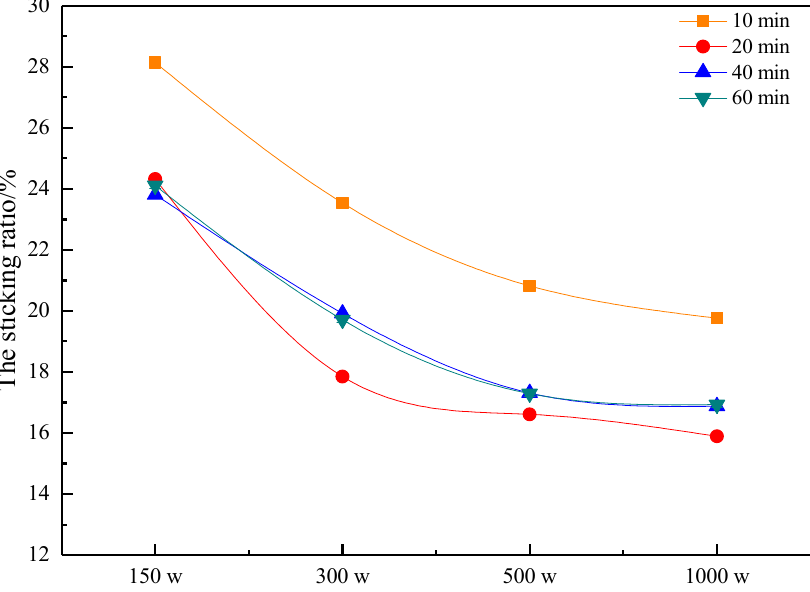
Figure 6. Changes of the ultrasonic field bond ratio over time with different applied power.